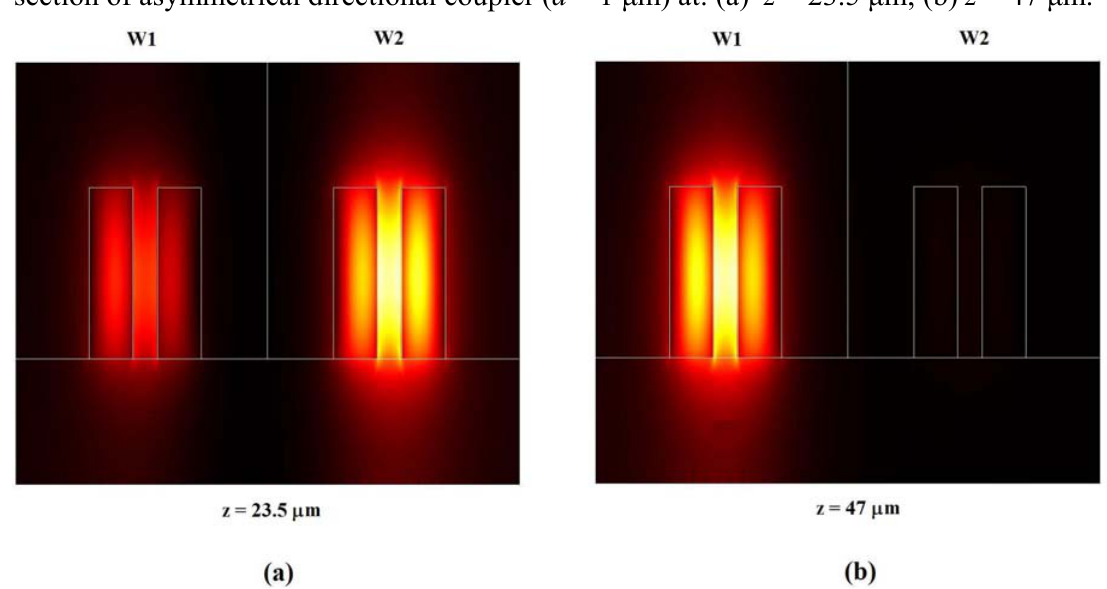
Figure 6. Optical intensity (quasi-TE mode by EME method) distribution in the cross- section of asymmetrical directional coupler ( d = 1 μ m) at: (a) z = 23.5 μ m; (b) z = 47 μ m.